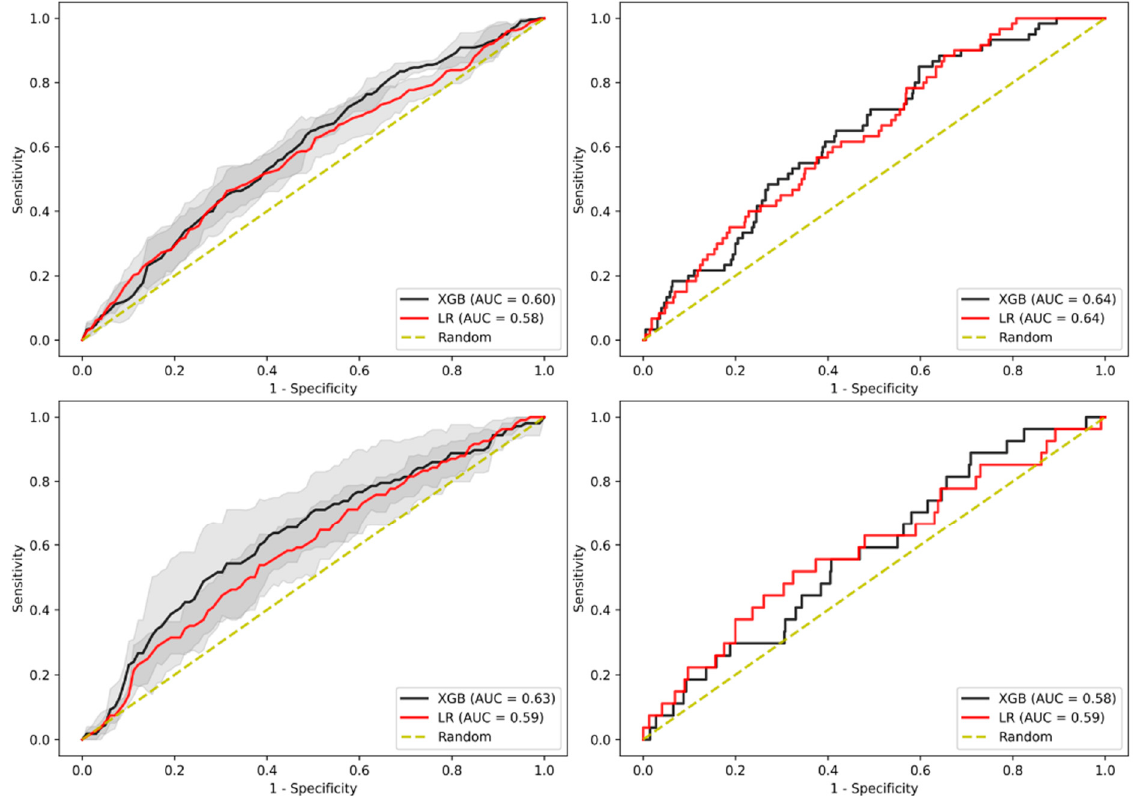
Figure 5. AUC-ROC performance of the XGBoost (XGB)-based model and LR-based model to identify patients with AA when separating cohort between male ( top ) and female patients ( bottom ). Internal validation cohort ( left ) and test cohort ( right ). Confidence intervals of 95% are shown in shaded grey.